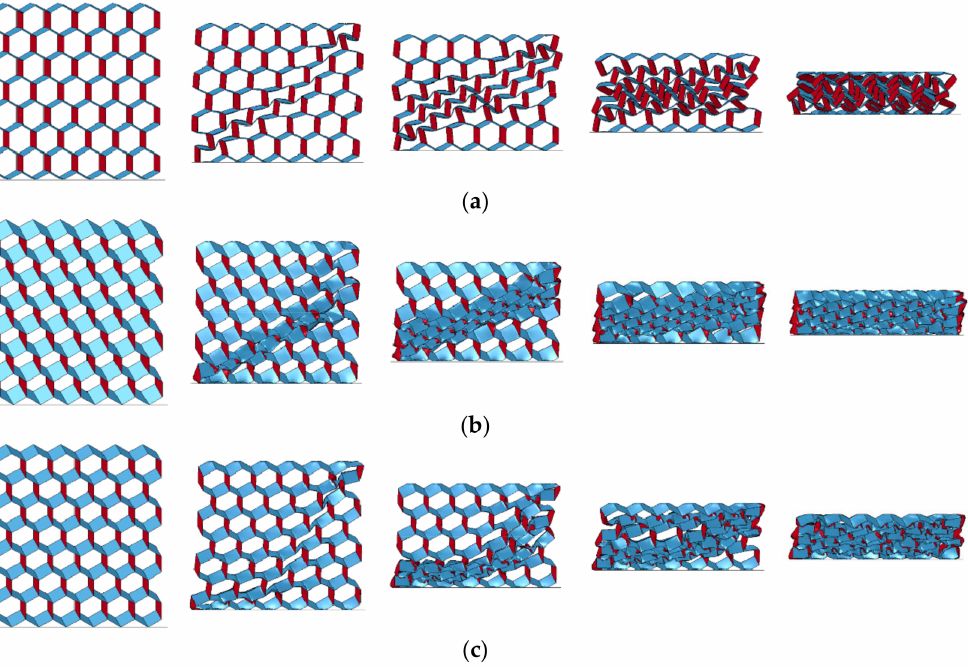
Figure 7. In-plane crushing deformation of origami honeycomb along the x -coordinate: ( a ) symmetri- cal deformation pattern, ( b ) one-sided deformation pattern, and ( c ) compound deformation